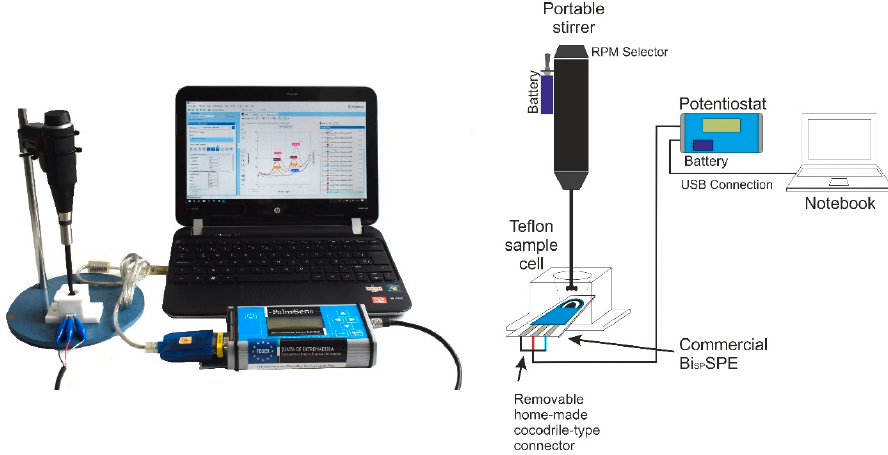
Figure 1. Schematic of the experimental setup for the on-site determination of Cd(II) and Pb(II) by Bi SP SPE